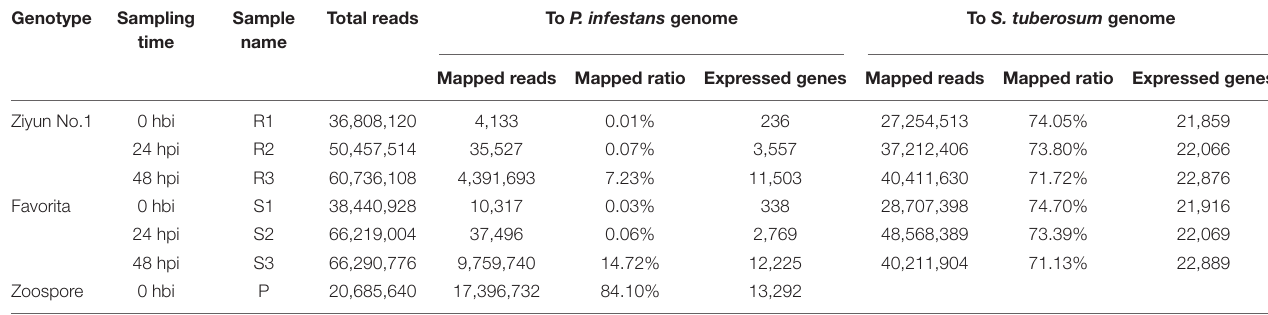
TABLE 1 | Comparison statistics of clean reads mapped to Phytophthora infestans ( P. infestans ) or genome.